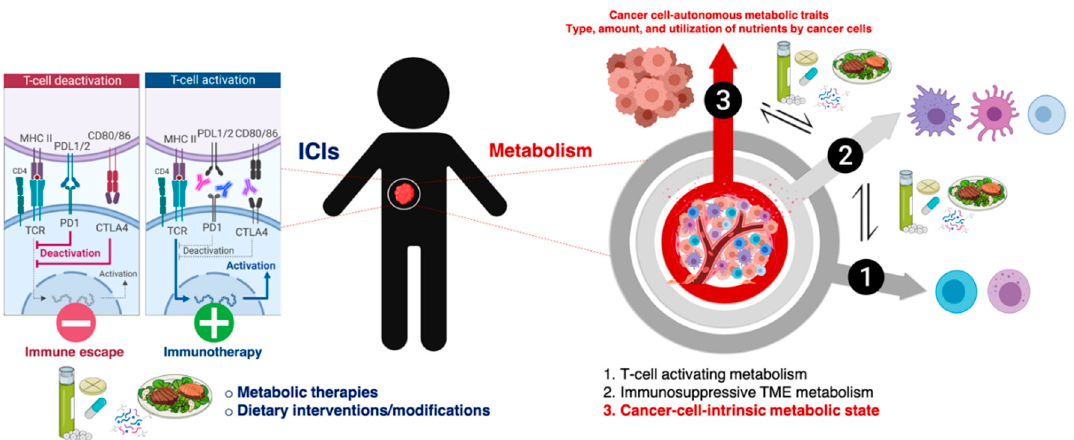
Figure 1. A three-layer metabolic regulation of the interface between tumor immune evasion and T-cell-directed immune checkpoint inhibitors . Layer 1 : Metabolic specialization of T-cells . The activation, proliferation, and differentiation of T-cells are governed by dynamic changes in metabolic pathways involving glucose uptake/metabolism, mitochondrial function, amino acid uptake, and cholesterol/lipid synthesis. Layer 2: Immunosuppressive tumor microenvironment (TME) metabolism. Cancer cells compete with effector T-cells in the TME for the same pool of nutrients, leading to the strong inhibition of T-cells; the immunosuppressive activity of certain immune compartments (e.g., M2-polarized tumor-associated macrophages (TAM), myeloid-derived suppressor cells (MDSC), and regulatory T (T reg ) cells) is highly dependent on the metabolic switches occurring in the TME. Layer 3: Cancer cell metabolic state. Certain metabolic nodes might suffice to drive the composition of the immune checkpoint landscape in cancer cells and the responsiveness of cancer cells to immunotherapy; diet-mediated changes in nutrient availability/utilization by cancer cells could have a similar impact on both the composition and/or functionality of the immune-escape mechanisms and the efficacy of immune checkpoint inhibitors. The amount, type, and utilization of nutrients derived from the diet as well as diet-altered activity of gut and tumor microbiota may influence not only the cell-autonomous metabolic capacity of cancer cells to shape their immune checkpoint landscape, but also the immunosuppressive metabolic features of the TME, and the metabolic specialization of T-cells. The pharmacological and dietary modulation of metabolic pathways, metabolites, and/or metabolic enzymes responsible for the antagonistic (e.g., tumor cells versus effector/cytotoxic T-cells) and symbiotic (e.g., tumor cells, TAM, MDSC, and T reg cells) interplays of the TME and the microbiota might elevate the response rates of cancer immunotherapy. Balancing the inhibition of layers 2 and 3 while boosting layer 1 remains challenging without the delineation of the metabolic and dietary blueprints that shape the immune checkpoint landscape of tumor cells.